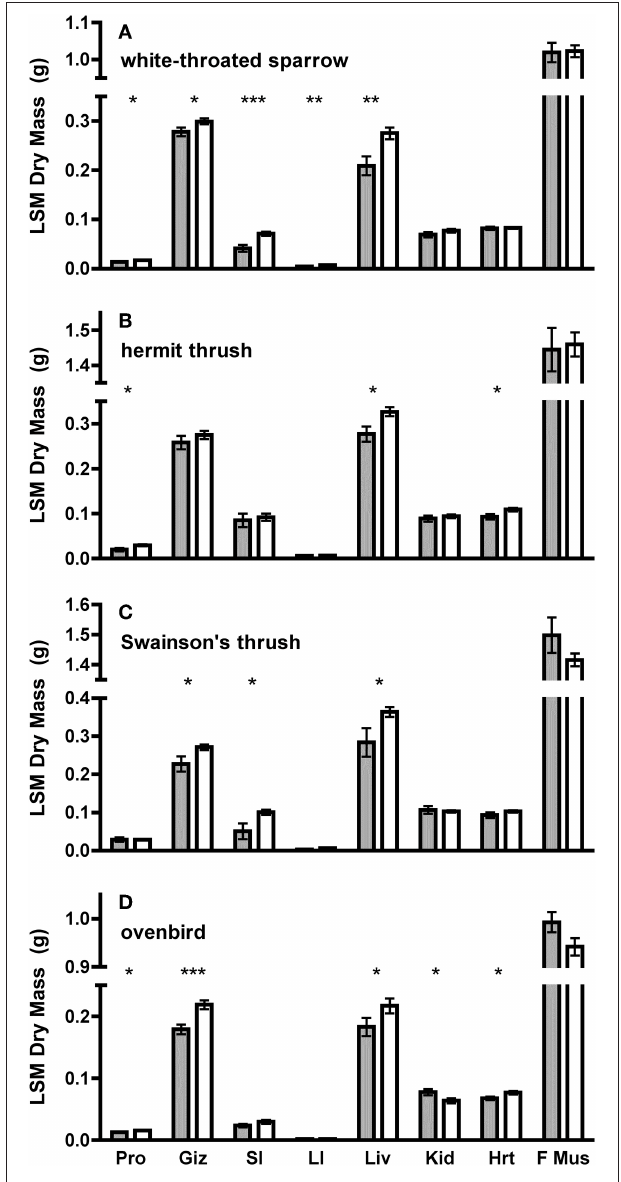
FIGURE 2 | Least square means ( ± SE) dry masses of organs from ANCOVA using SizePC1 as a covariate of adult and juvenile (A) white-throated sparrow, (B) hermit thrush, (C) Swainson’s thrush, and (D) ovenbird. SizePC1 is a principal component containing tarsus and keel measurements for (B) hermit thrush, (C) Swainson’s thrush, and (D) ovenbird, and tarsus, keel, and bill measurements for (A) white-throated sparrow. Gray bars represent adults and white bars represent juveniles. Organs are: Pro, proventriculus; Giz, gizzard; SI, small intestine; LI, large intestine; Liv liver; Kid, kidney; Hrt, heart; and F Mus, flight muscle (pectoralis and supracoracoideus). Asterisks denote differences between juveniles and adults at P < 0.05 (*), P < 0.01 (**), or P < 0.01 (***). Comparisons of Pro, Giz, SI, LI, and Liv used one-tailed tests predicting larger dry masses among juveniles, whereas comparisons of Kid, Hrt, and F Mus used two-tailed tests. than adults [ F (1,67) = 3.84, P = 0.054], and OrganPC2 scores of juvenile ovenbirds were very close to being significantly higher than adults [ F (1,41) = 3.954, P = 0.053]. The